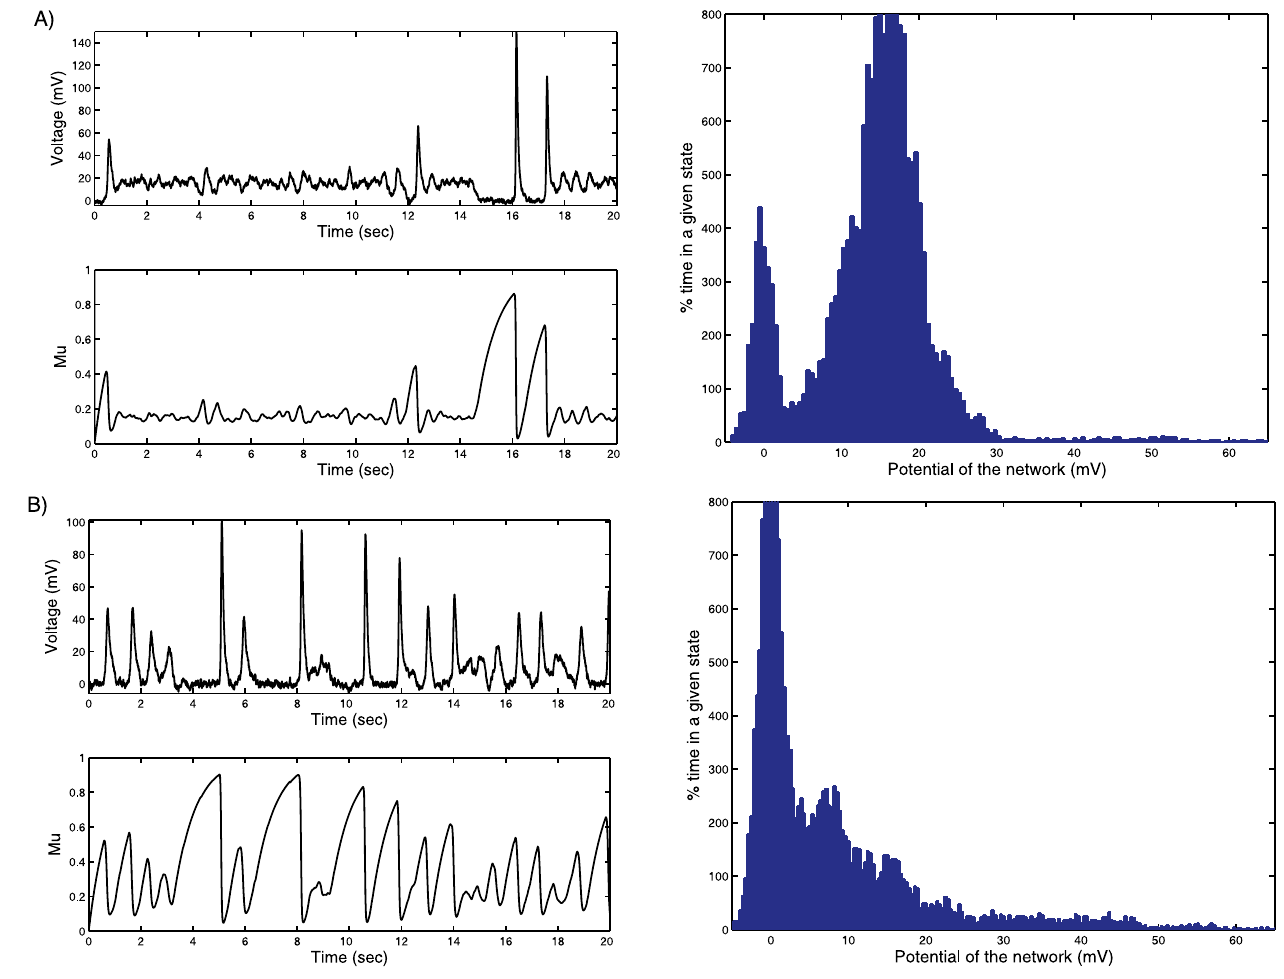
Figure 4. Effect of Synaptic Plasticity on Up–Down State Dynamics (A) Effect of increasing w T , which is equivalent to the LTP effect. The effect of LTP is obtained by increasing the total synaptic connections w T to a value of 15. The effect is similar to a depolarization injection current. (B) Effect of LTD on Up–Down state dynamics . The effect of LTD is obtained by decreasing the total synaptic connections w T to a value of 11. The effect is similar to hyperpolarizing the ensemble of neurons. DOI: